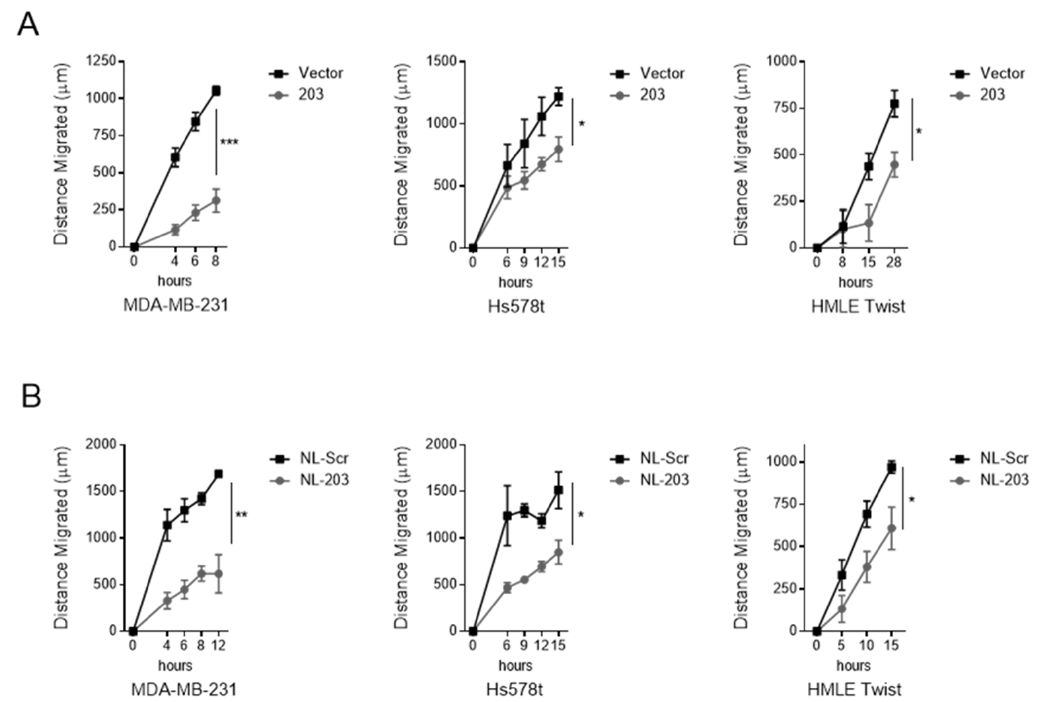
Figure 2. miR-203 inhibits migration. ( A ) Migration in indicated cell lines transduced with a retrovirus vector to stably overexpress miR-203. ( B ) Migration in indicated cell lines exposed to microRNA mimic-loaded nanoliposomes at a concentration of 85 µ M for 48 h. Assay performed in quadruplicates. Represented as mean ± standard deviation of change in gap length from t = 0. p -value calculated for final measurement using Student’s two-tailed t -test. * p < 0.05, ** p < 0.01, *** p < 0.001 .